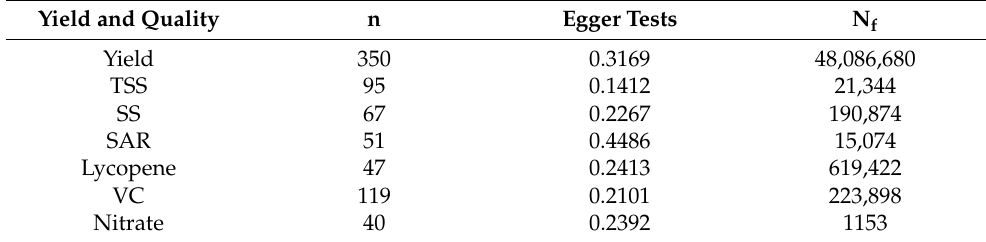
Table 1. Exploring potential publication bias and robustness by Egger tests and Rosenberg’s fail-safe numbers (N f